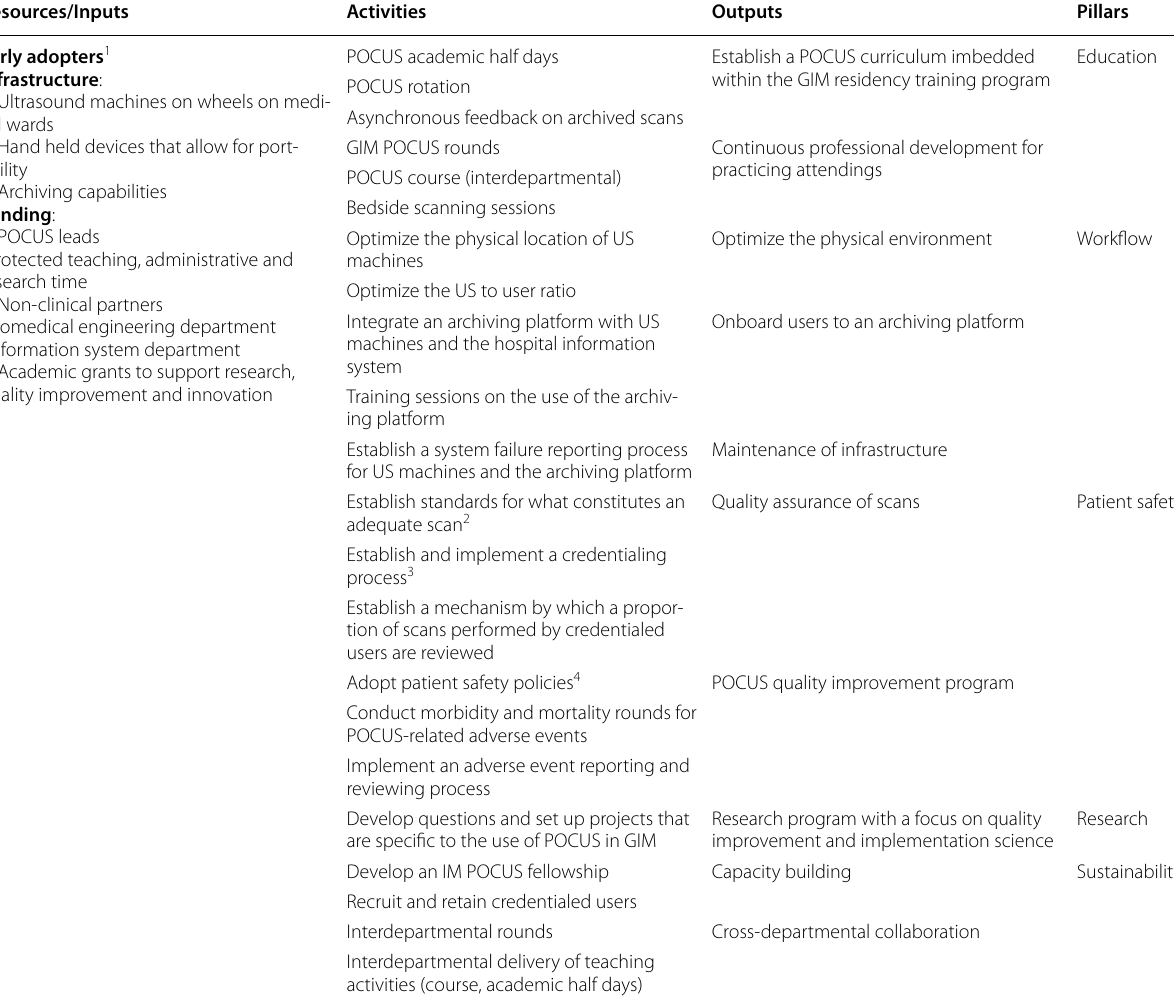
Table 3 GIM‑POCUS program logic model: resources, activities, and